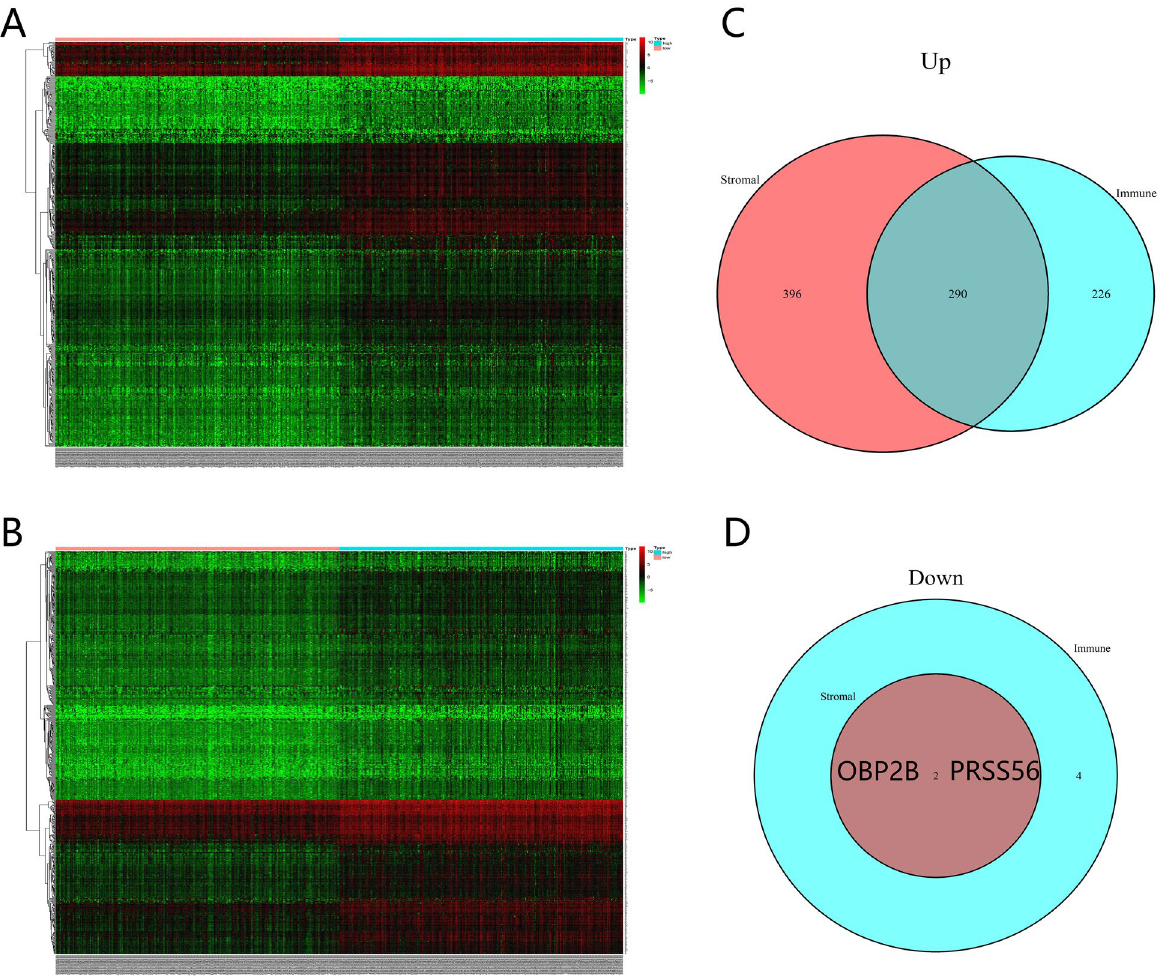
Figure 2. Analysis of gene expression profiles with immune scores and stromal scores. Heatmaps show differentially expressed gene profiles between high and low immune scores/stromal scores groups. ( A Immune scores, ( B ) Stromal scores, low score in left and high score in the right; Red represents higher expression genes, and green represents lower expression genes, black represents same expression genes; |log2fold-change| > 1.5, FDR < 0.05). Venn plots revealed 292 intersect genes, including 290 upregulated genes in higher immune/ stromal scores ( C ) and 2 down-regulated genes in lower immune/stromal scores ( D